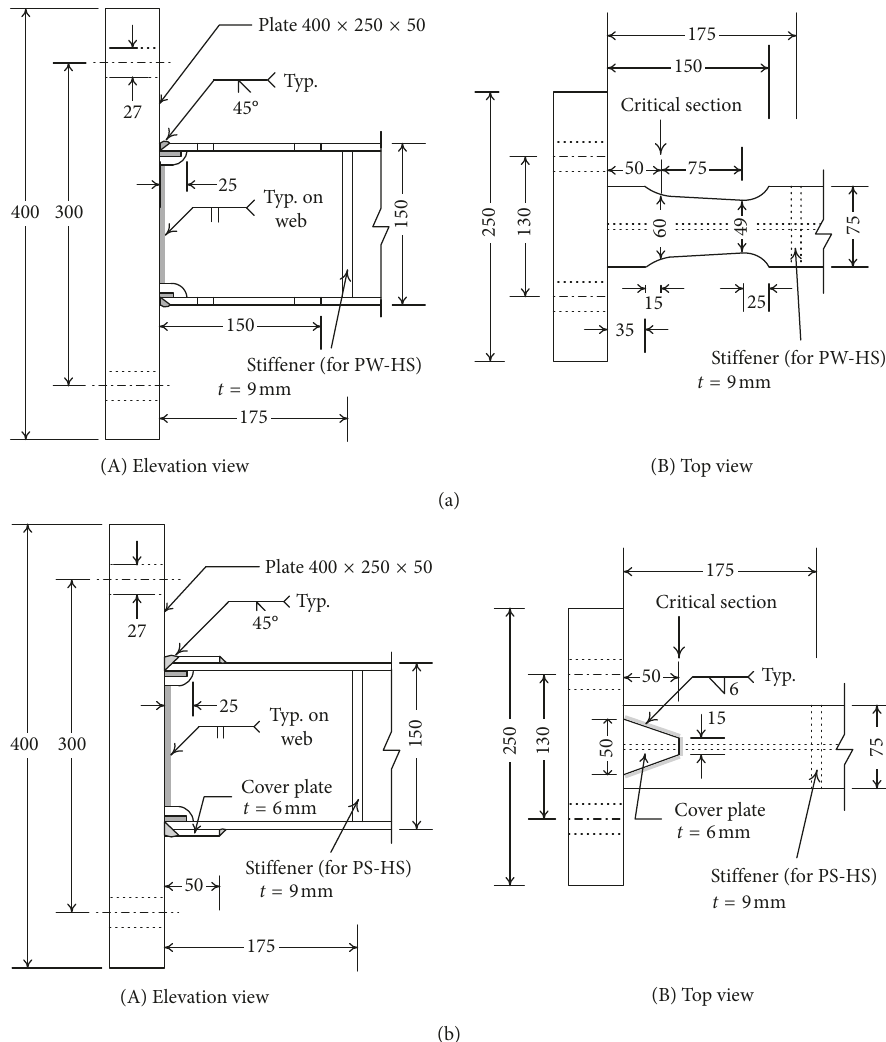
Figure 5: Detail of beam-to-column connection for the H shape (unit: mm). (a) WBC connection. (b) SBC connection.